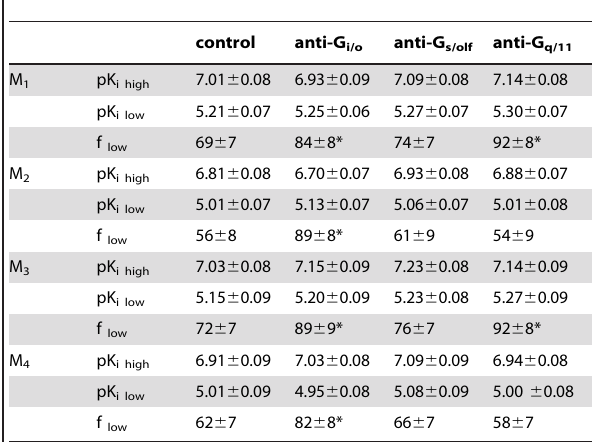
Data are means 6 S.E.M. From 3 experiments performed in quadruplicates. f low , fraction of low-affinity sites in percent; *, significantly different from control by t-test (P , 0.05).